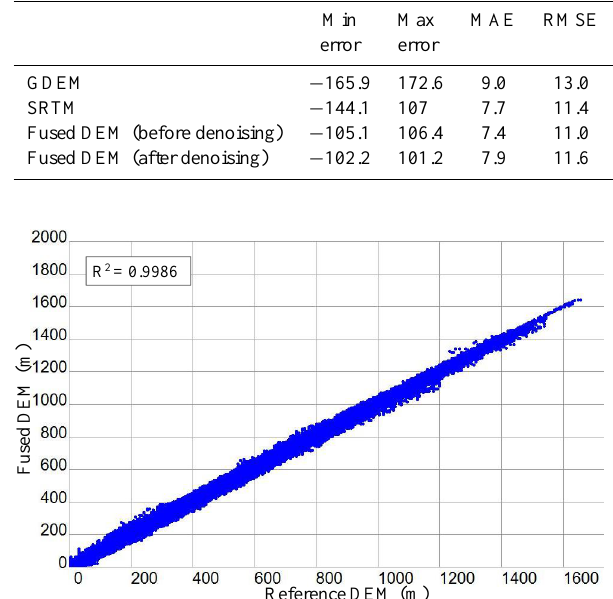
Table 7. Comparison of differences in some terrain parameters of GDEM, SRTM and the fused DEM with respect to the reference DEM.